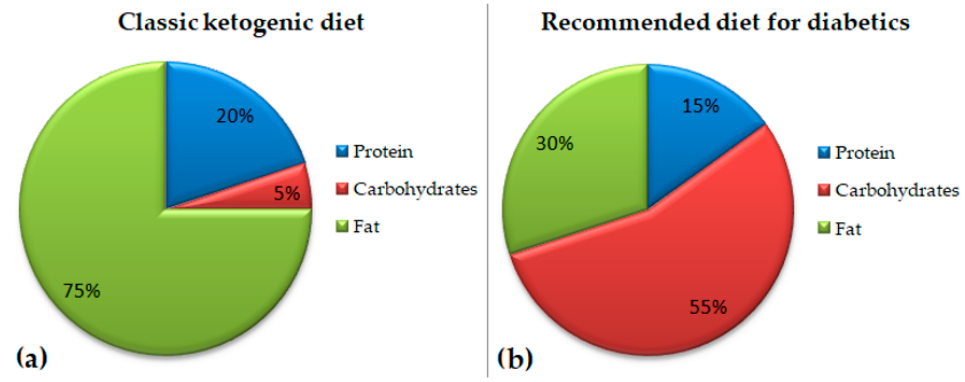
Figure 3. Comparison of an exemplary macronutrient ratio in the classic ketogenic diet ( a ) with that in an exemplary diabetic diet ( b ).